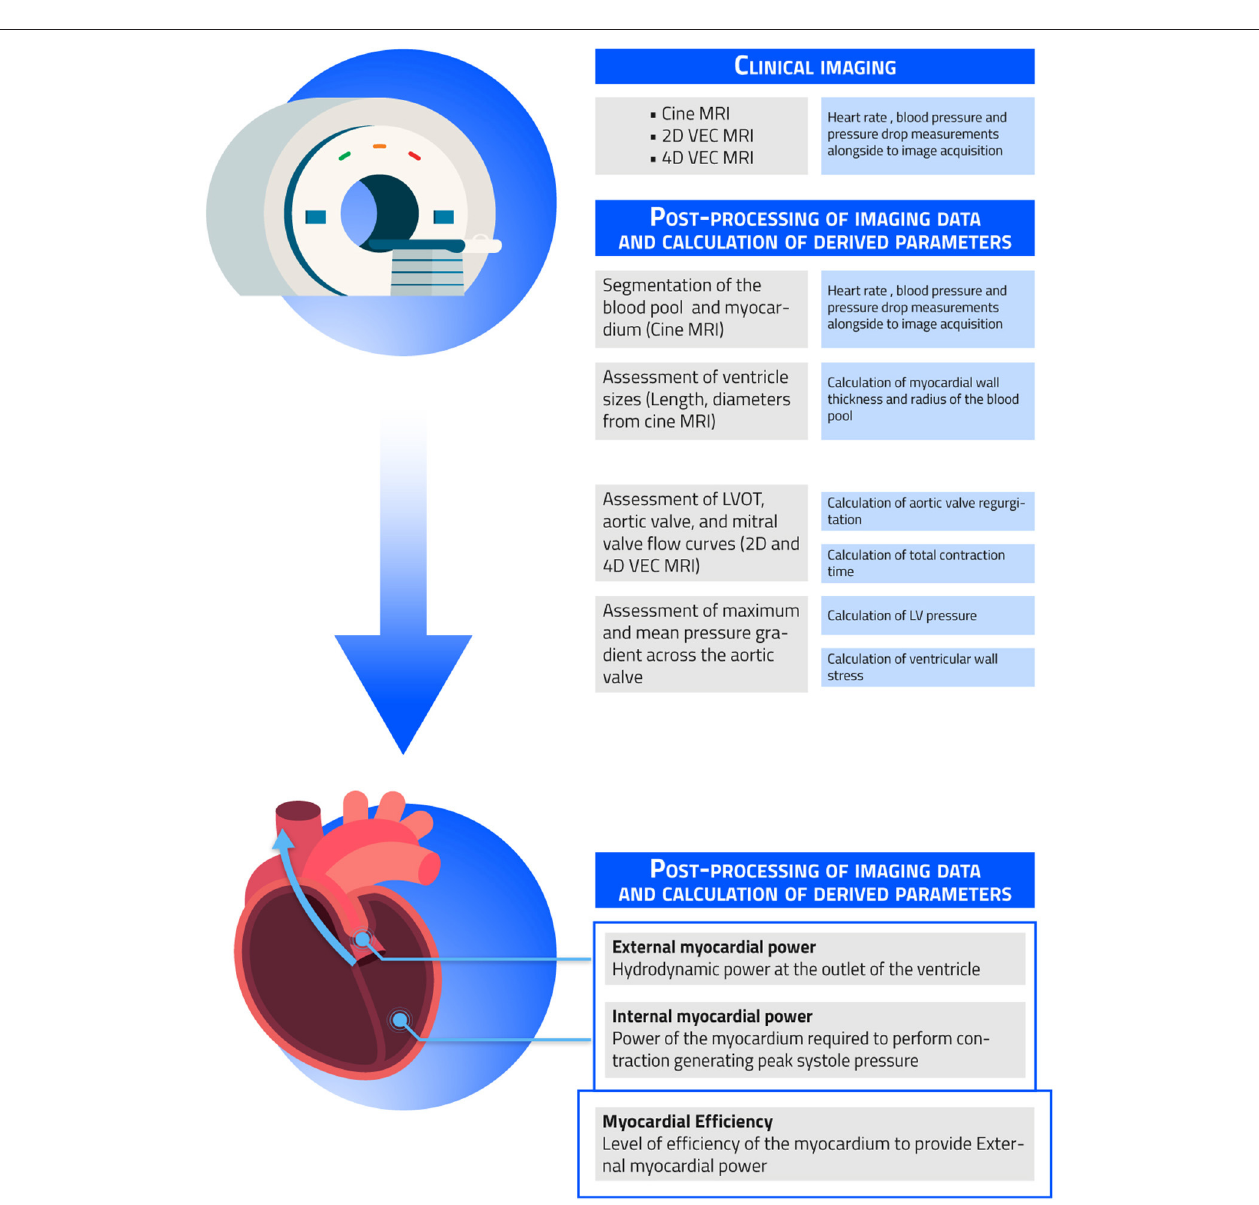
FIGURE 1 | Clinical imaging and post-processing workflow. Shown in the figure are the necessary steps needed to obtain the non-invasively measured external myocardial power, internal myocardial power, and myocardial efficiency.